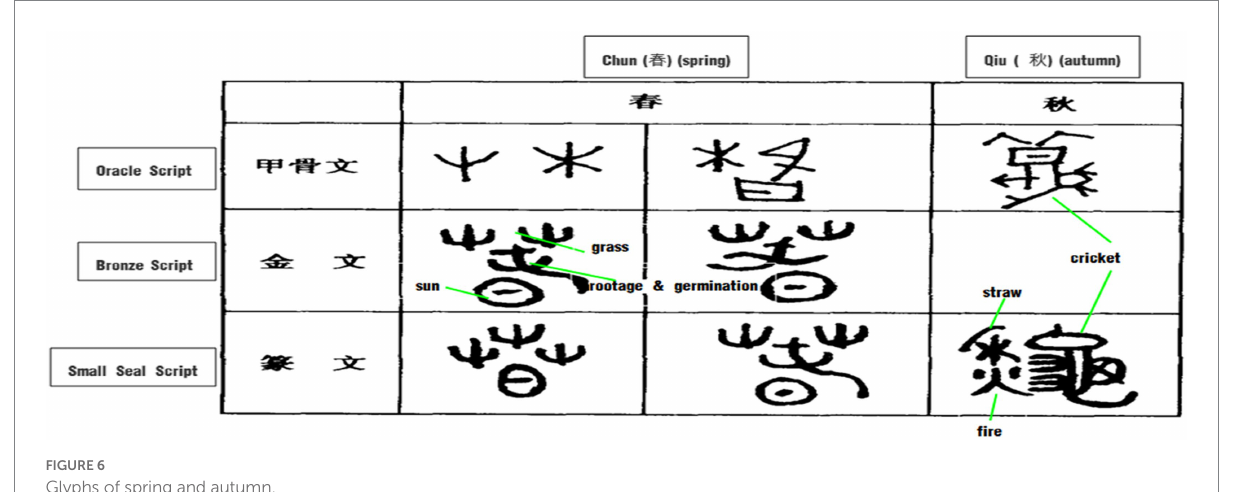
FIGURE 6 Glyphs of spring and